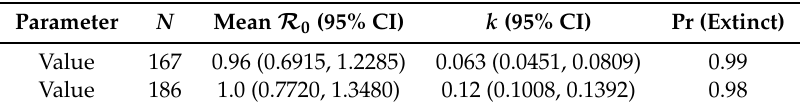
Table 2. Parameter estimation results of the LS model; estimates of the reproduction number R 0 and the dispersion parameter k of the 2015 Middle Eastern respiratory syndrome